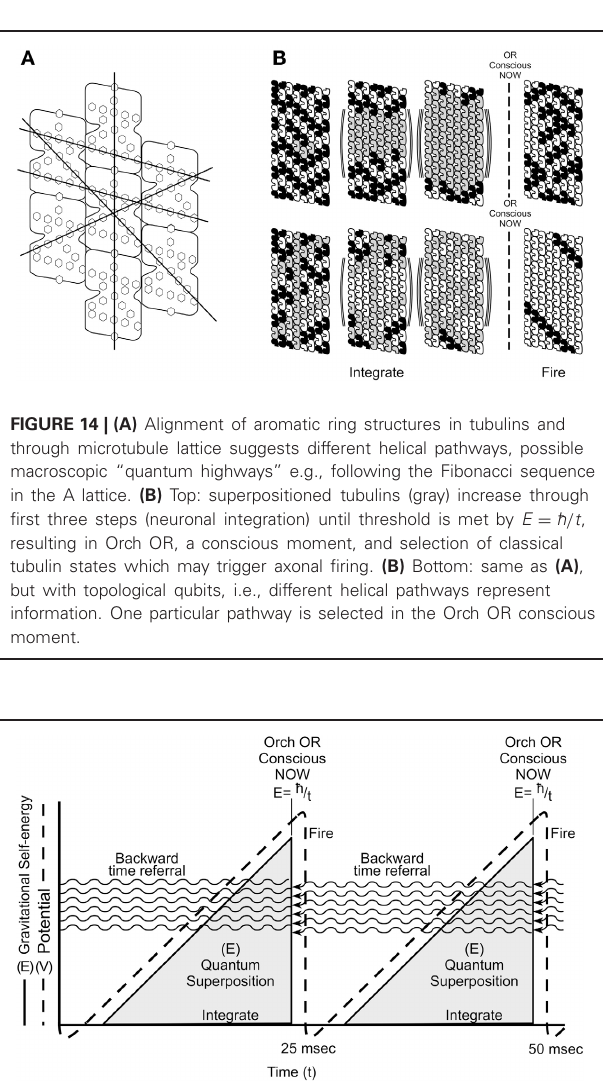
FIGURE 15 | Two Orch OR events (solid lines) underlie integrate-and-fire electrophysiology (dotted lines) in neurons. Orch OR and conscious moments occur here at t = 25ms (gamma synchrony), with E then equivalent to superposition of approximately 2 × 10 10 tubulins. Each Orch OR moment occurs with conscious experience, and selects tubulin states which can then trigger axonal firings. Each Orch OR event can also send quantum information backward in perceived